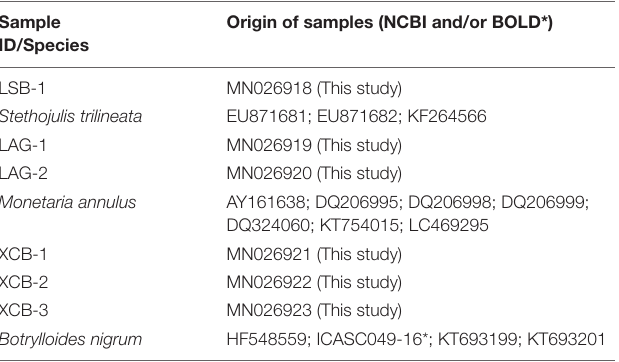
TABLE 1 | List of the partial sequences of COI gene with sample ID, species, and origin of samples. Sample Origin of samples (NCBI and/or BOLD*) ID/Species